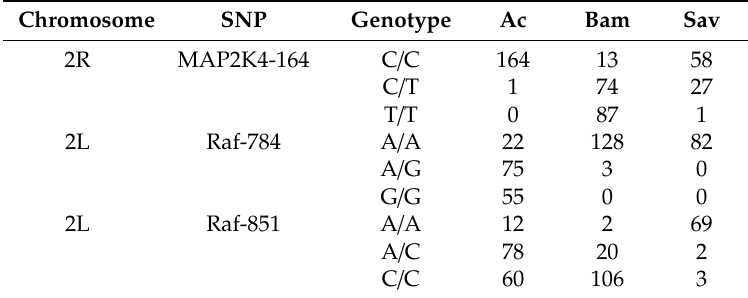
Table 2. Distribution of SNP genotypes among potentially functional SNPs. Results support the hypothesis that these are under significant selection among taxa ( α < 0.05). Numbers indicated number of individuals observed per genotype.